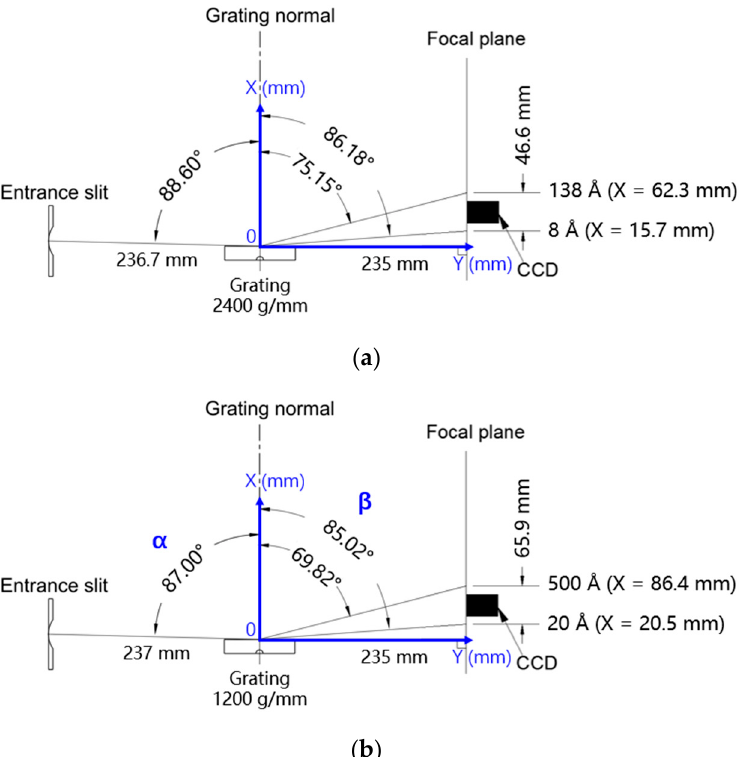
Figure 1. Top view of optical layout of ( a ) EUV_ Short and ( b ) EUV_Long spectrometer.